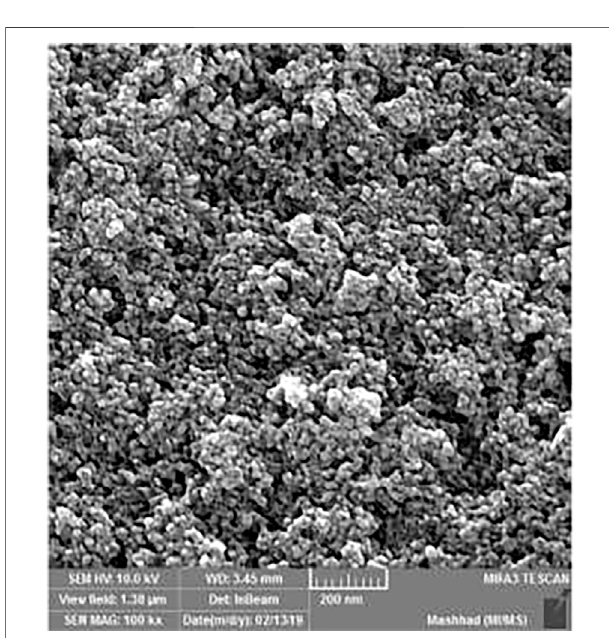
Frontiers in Chemistry |